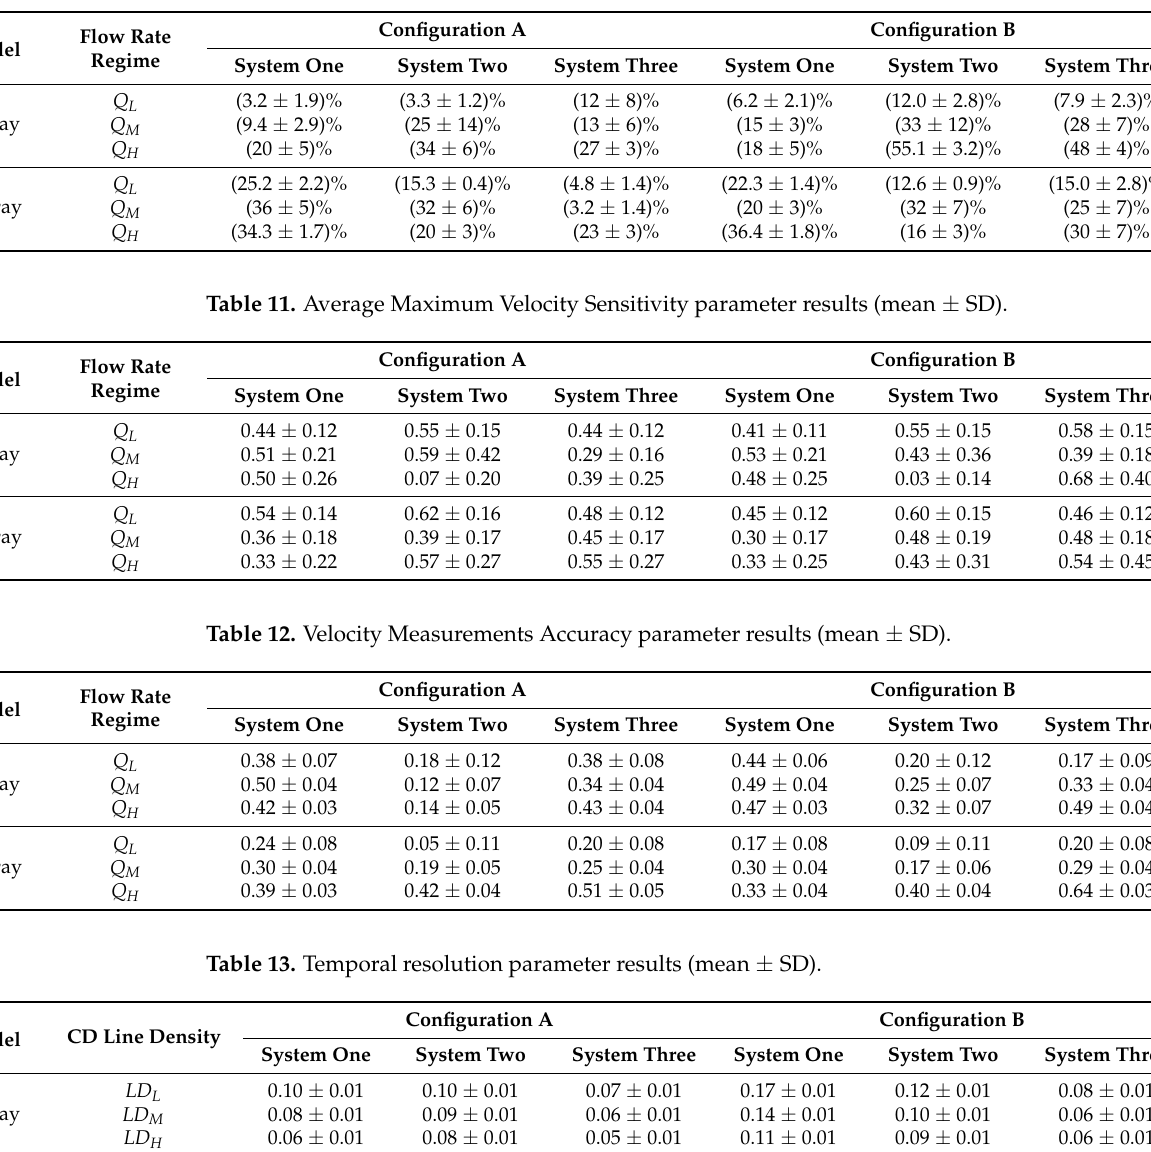
Table 10. Percentage registration error parameter results (mean ± SD).